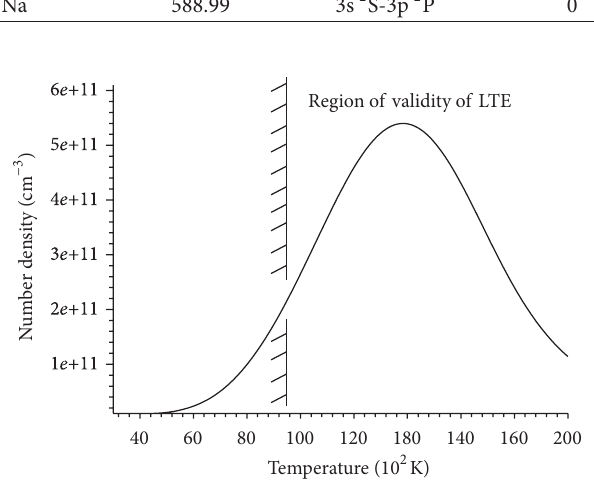
F 3: Population of excited level Na(3p), as function of temperature, in the equilibrium plasma of MgCl -NaCl solution concentrated at 2